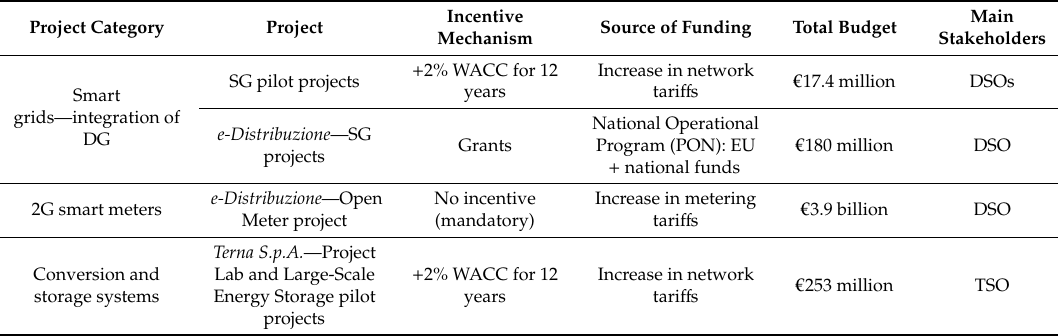
Table 4. Overview of network innovation projects in